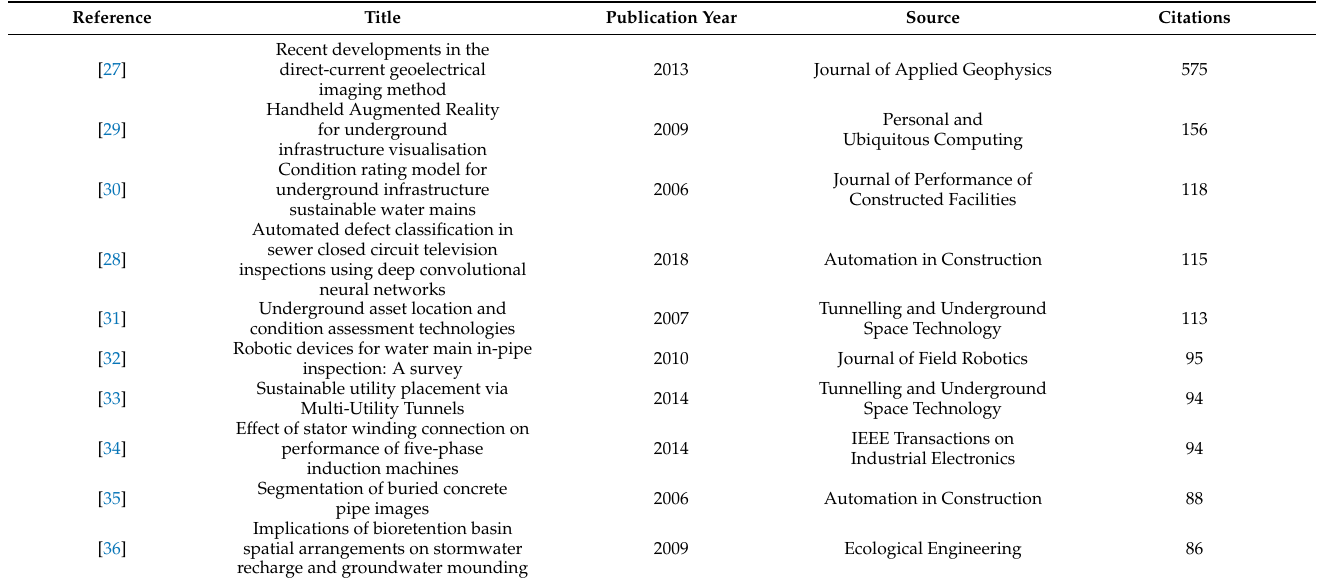
Figure 5. The number of published UI-related articles by different authors. Table 2. Top 10 most cited